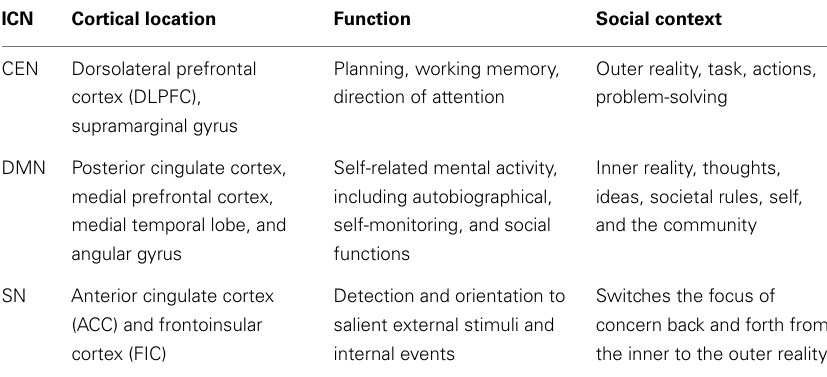
Table 1 |The three major ICNs and their implications in bvFTD